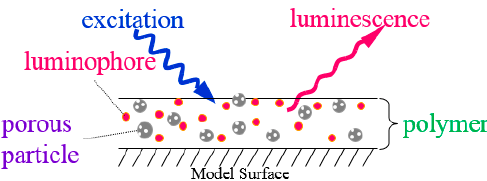
Figure 2. Schematic description of a polymer-ceramic PSP (PC-PSP).